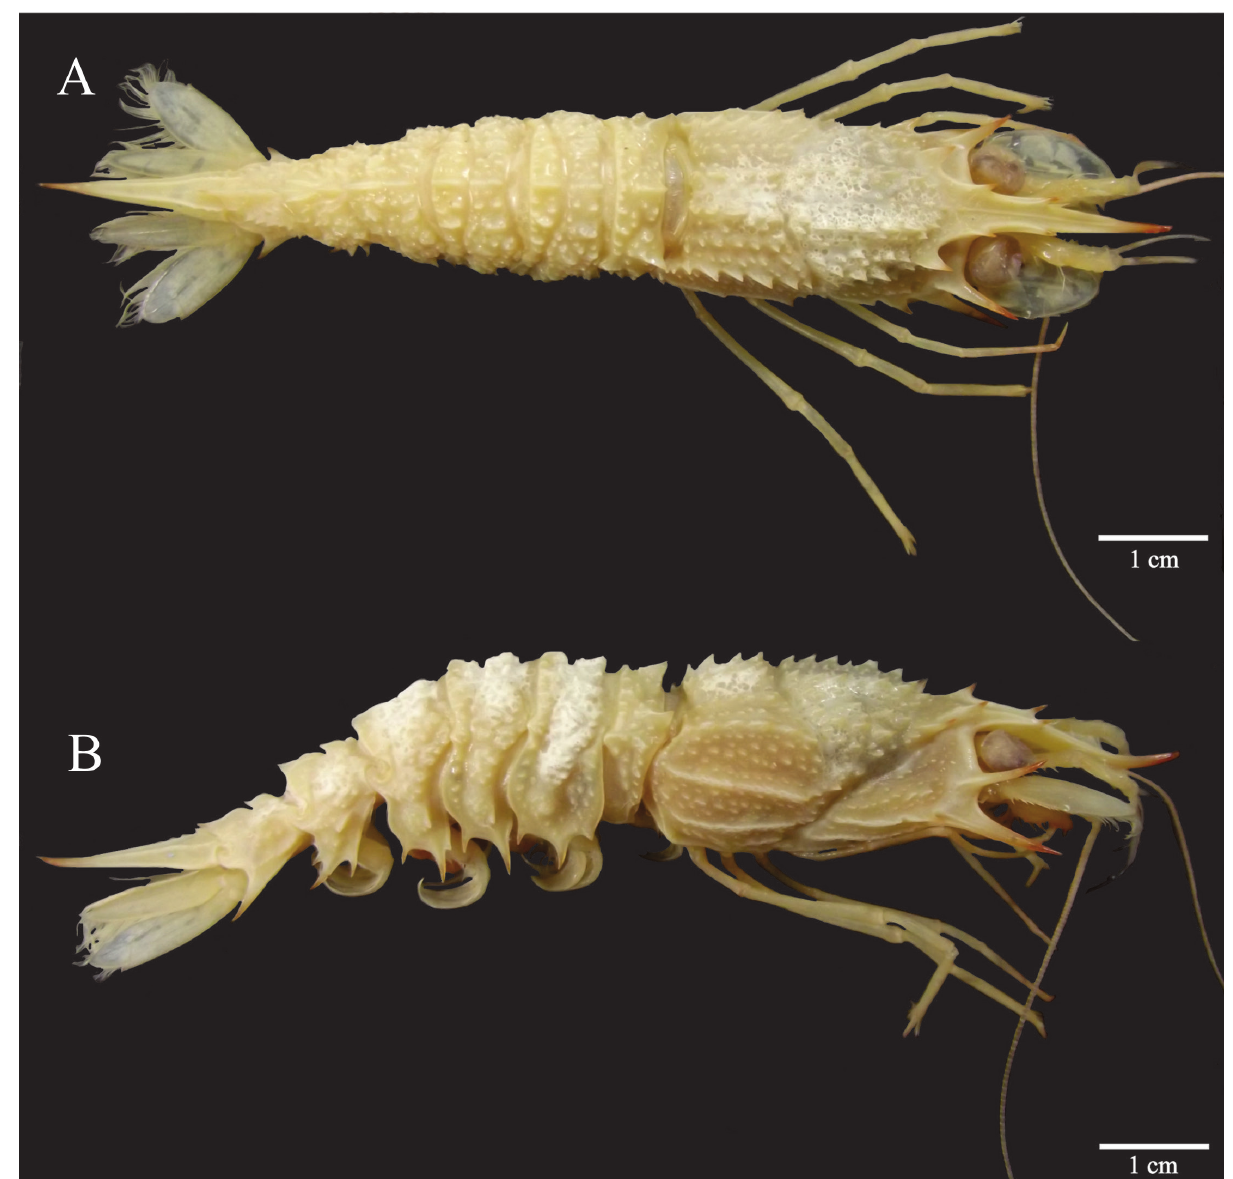
Figure 5. Glyphocrangon sculpta (Smith, 1882), dorsal (A) and lateral (B) views, ovigerous female (TL-98.2 mm; Bpot-Talude MT# 82; MOUFPE 15.193), northeastern